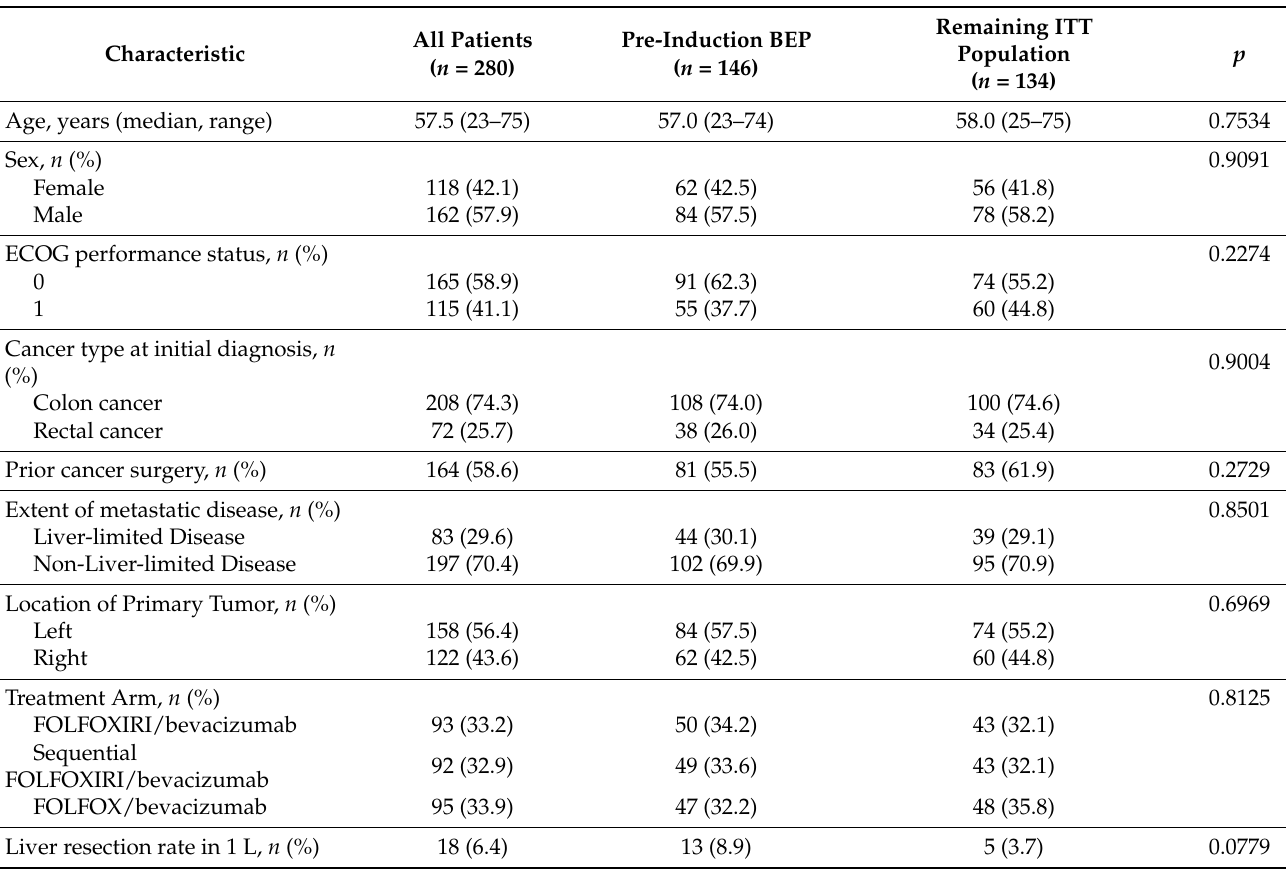
Table 1. Comparison of patient characteristics between pre-induction BEP and